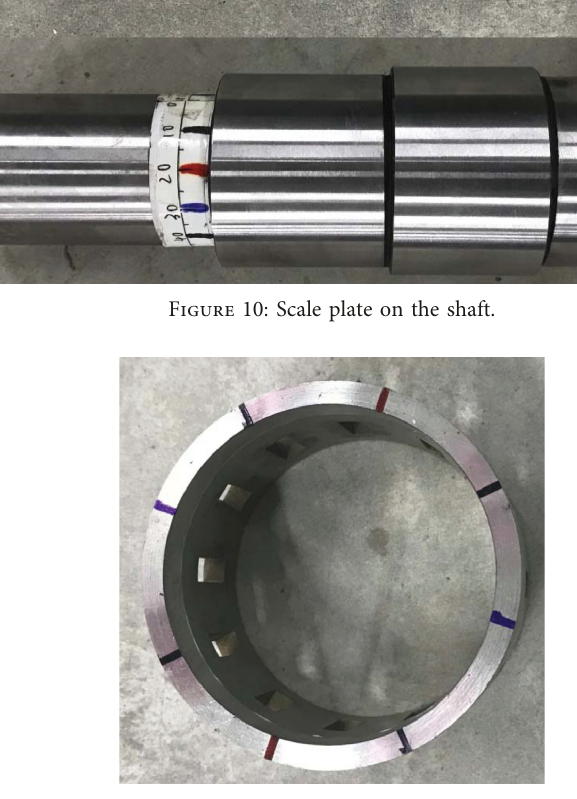
Figure 11: Scale plate on the sleeve.